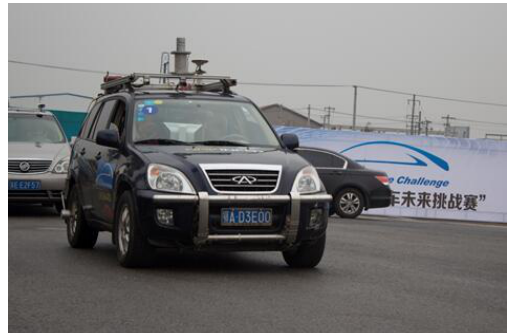
Fig 8.’TuZhi’ self-driving car.